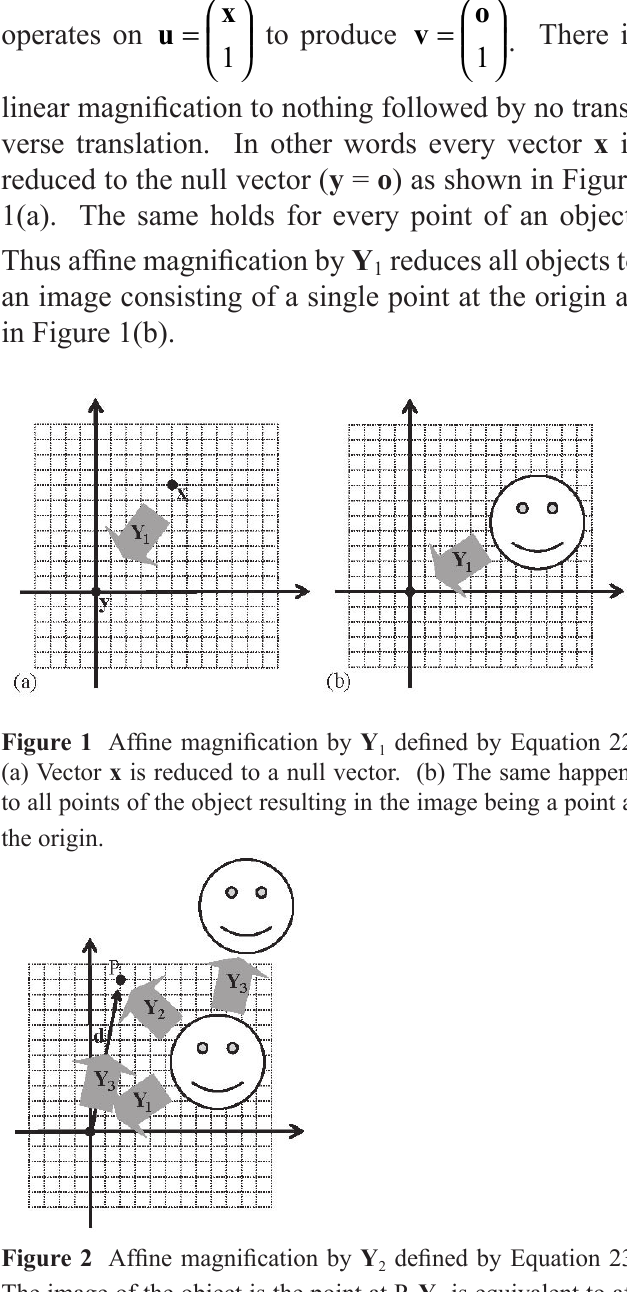
defined by Equation 23. 2 is equivalent to af- 2 followed by affine magnification Y 1 3 acts first then the object 3 1